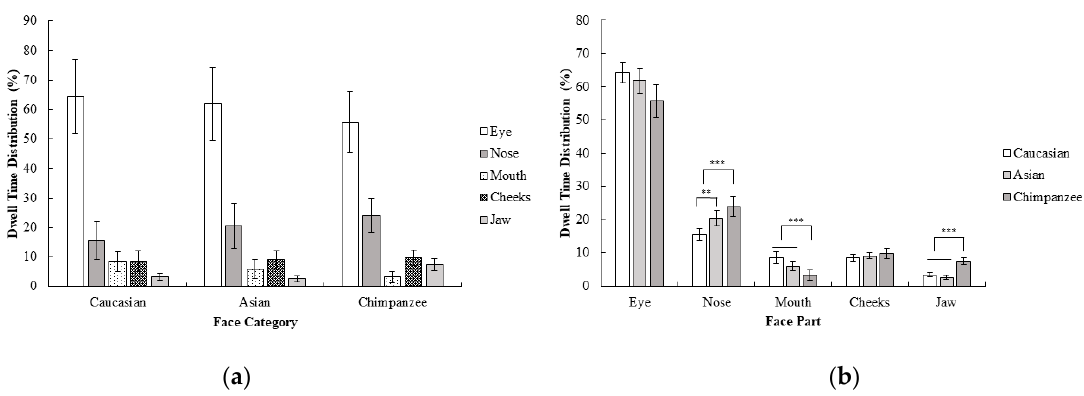
Figure 2. Mean percentage (with 95% CI) of dwell time as a function of ( a ) face category and ( b ) face part in Experiment 1.